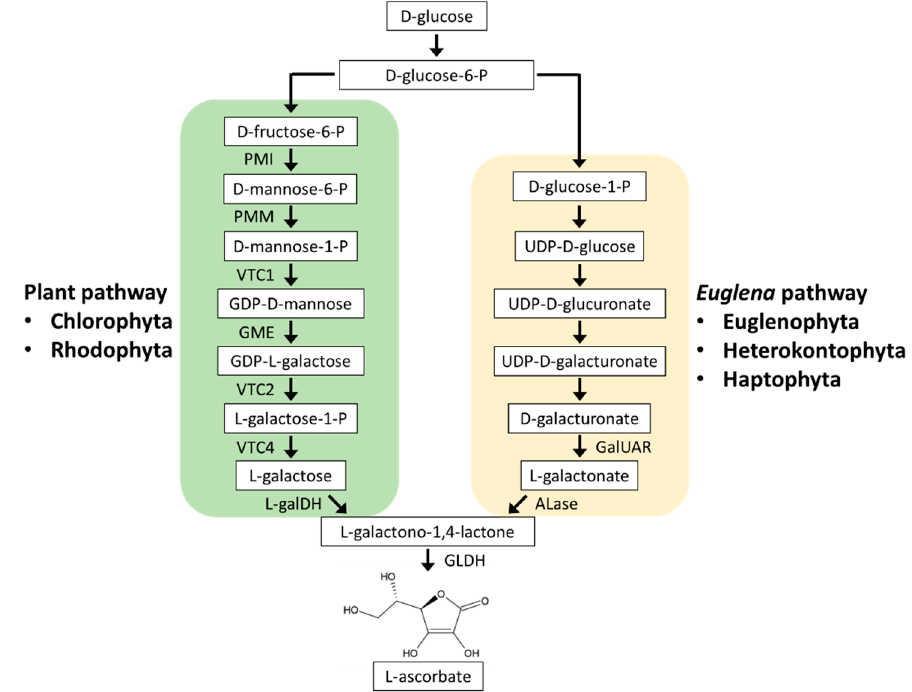
Figure 2. Ascorbate biosynthesis in microalgae. Microalgae use two distinct pathways: plant pathway (D-mannose/L-galactose pathway) or Euglena pathway (D-galacturonate pathway). Chlorophyta and Euglenophyta have been demonstrated to use the plant pathway and Euglena pathway, respectively. Rhodophyta lacking the VTC2 homolog are predicted to use a modified plant pathway including alternative L-galactose phosphorylase instead of VTC2. Heterokontophyta and Haptophyta are predicted to use the Euglena pathway. PMI, phosphomannose isomerase; PMM, phosphomannomutase; VTC1, GDP-L-mannose pyrophosphorylase; GME, GDP-D-mannose-3’,5’-epimerase; VTC2, L-galactose phosphorylase; VTC4, L-galactose-1-P phosphatase; L-galDH, L-galactose dehydrogenase; GLDH, L-galactono-1,4-lactone dehydrogenase; GalUAR, D-galac- turonic acid reductase; ALase, aldonolactonase.